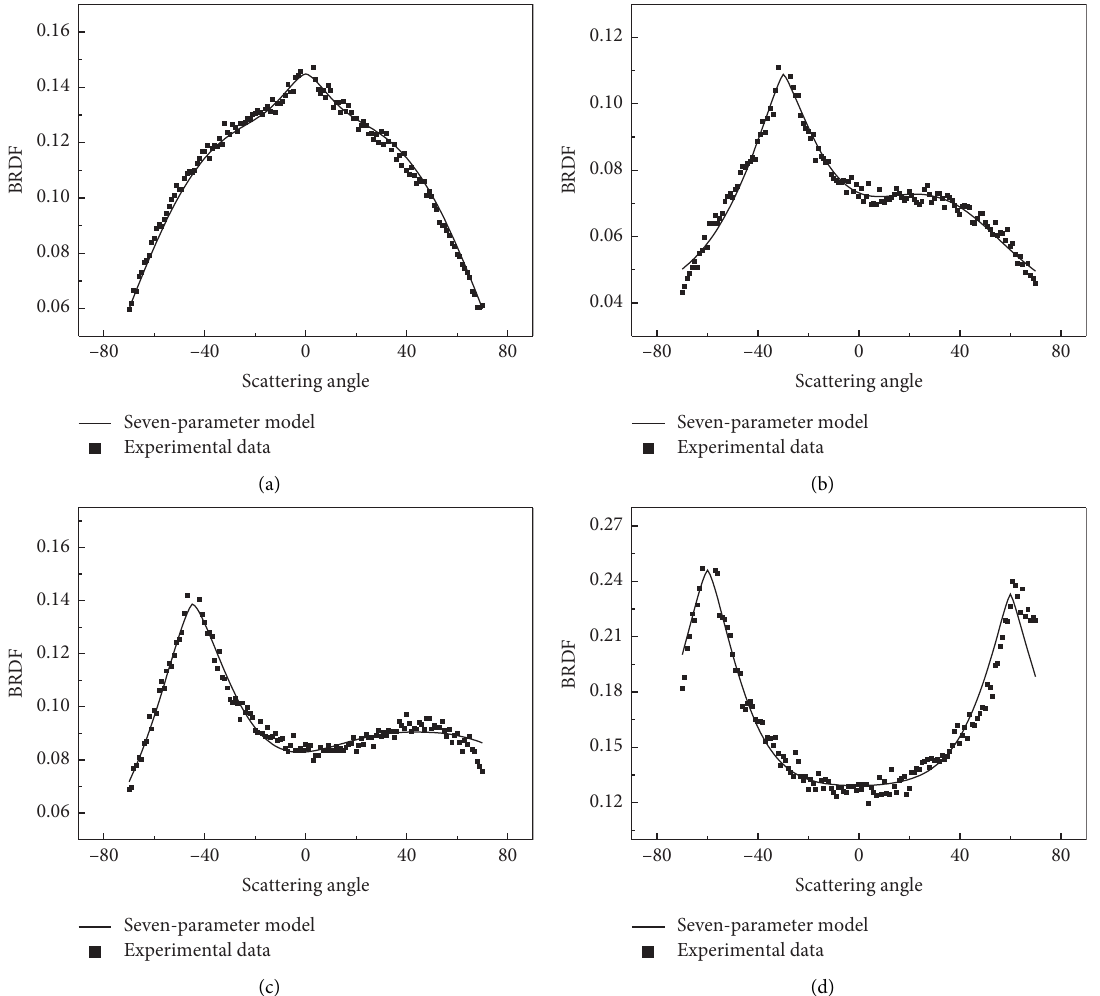
Figure 3: Fitted curve of Martian soil. (a) Fitted curve of 0 ° incident angle; (b) fitted curve of 30 ° incident angle; (c) fitted curve of 45 ° incident angle; (d) fitted curve of 60 ° incident